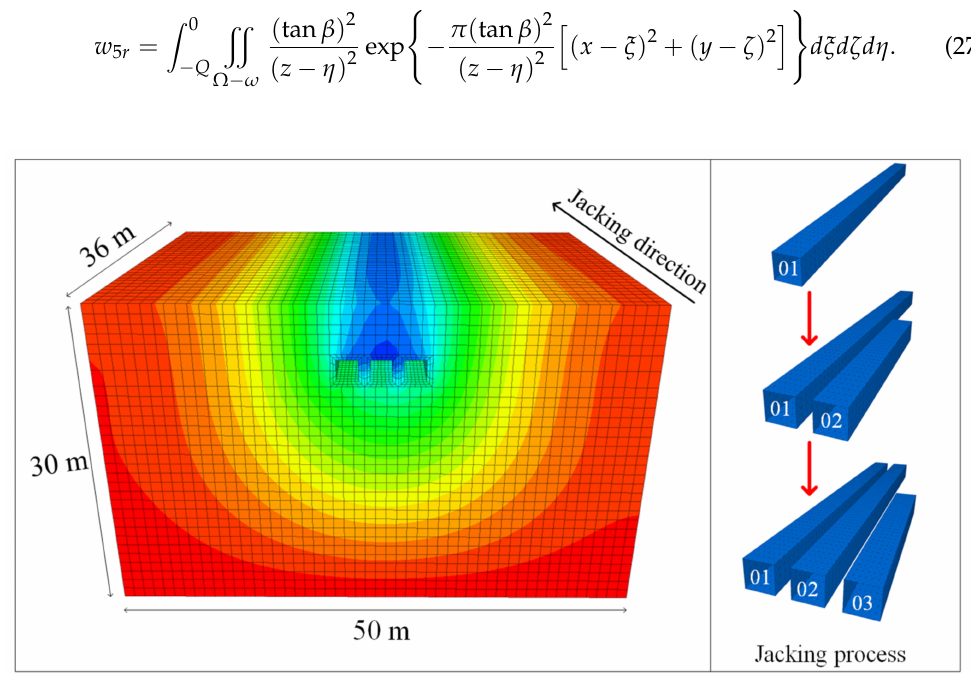
Figure 9. Numerical simulation model of pipe